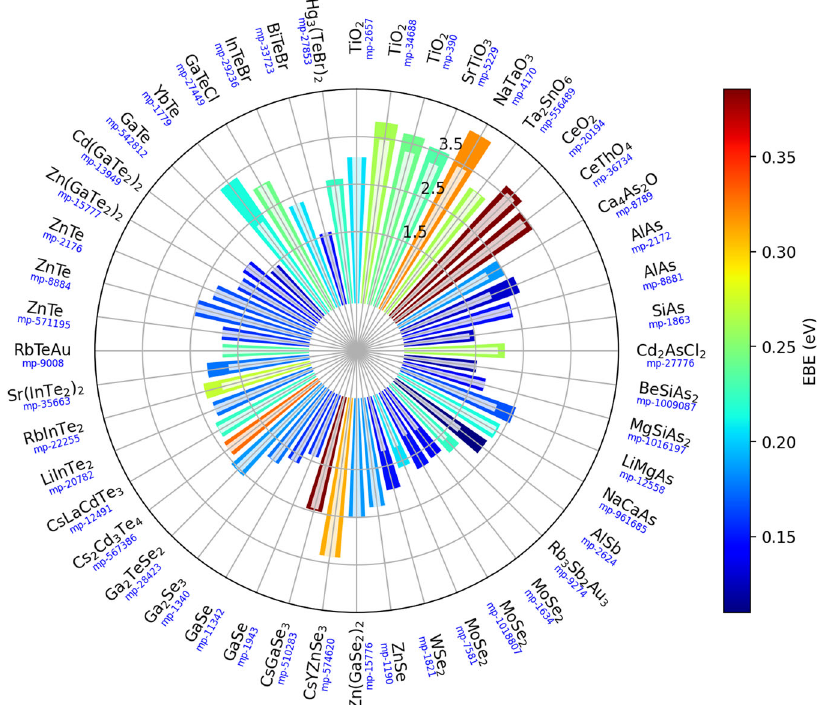
Fig. 2 The bar heights denote the optical gap, E G 0 W 0 (cid:1) BSE in eV, and their colors denote the exciton binding energy (EBE) as obtained from g G 0 W 0 -BSE calculations for the 48 materials. We fi nd that 26 of the 48 materials have EBE less than 0.2 eV. The radial heights corresponding to 1.5, 2.5, and 3.5 eV optical gaps are labeled in the fi gure. The indirect absorption edges are shown as white bars for each material. For direct gap materials, they are equal to the optical